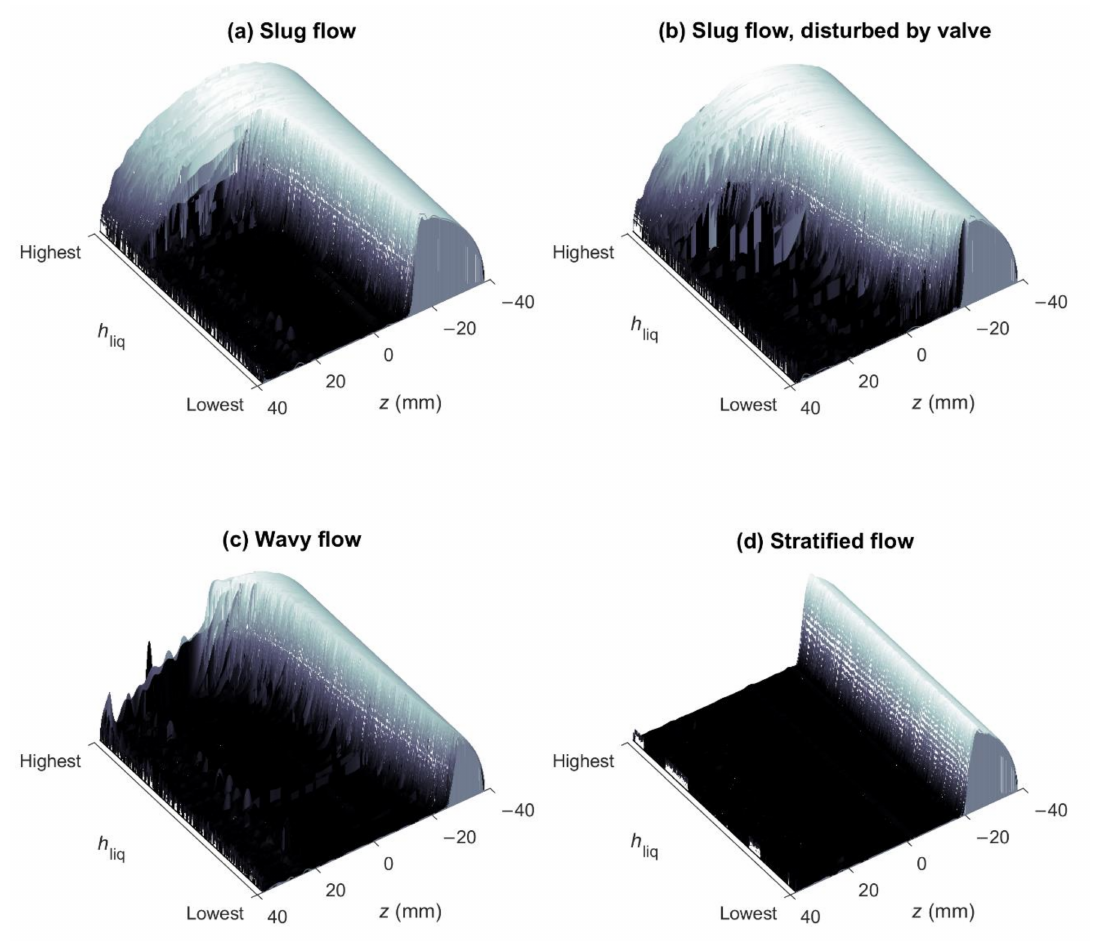
Figure 5. The set of liquid distribution images acquired in four different flow experiments represented as a surface plot in which liquid distribution images are sorted from the highest to lowest measured holdup. The axis labeled as z indicates the height along the flow tube with the pipe axis located at z = 0 mm. Each experiment corresponds to a unique multiphase flow profile: ( a ) Slug flow (Q gas = 11.5 m 3 /h and Q liq = 7.3 m 3 /h); ( b ) slug flow, disturbed by valve (Q gas = 10.4 m 3 /h and Q liq = 7.3 m 3 /h); ( c ) wavy flow (Q gas = 46.1 m 3 /h and Q liq = 2.6 m 3 /h); and ( d ) stratified flow (Q gas = 46.6 m 3 /h and Q liq = 1.1 m 3